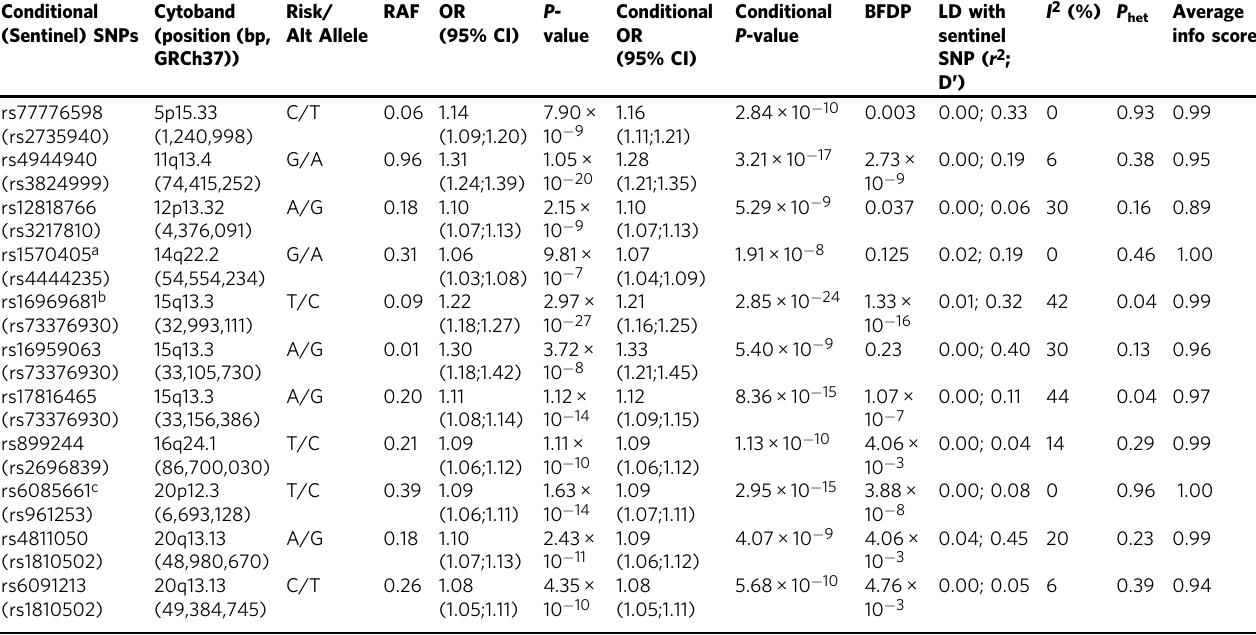
Table 2 Colorectal cancer variants identi fi ed in analysis conditioning on the sentinel SNP at each risk locus Conditional Cytoband (Sentinel) SNPs (position